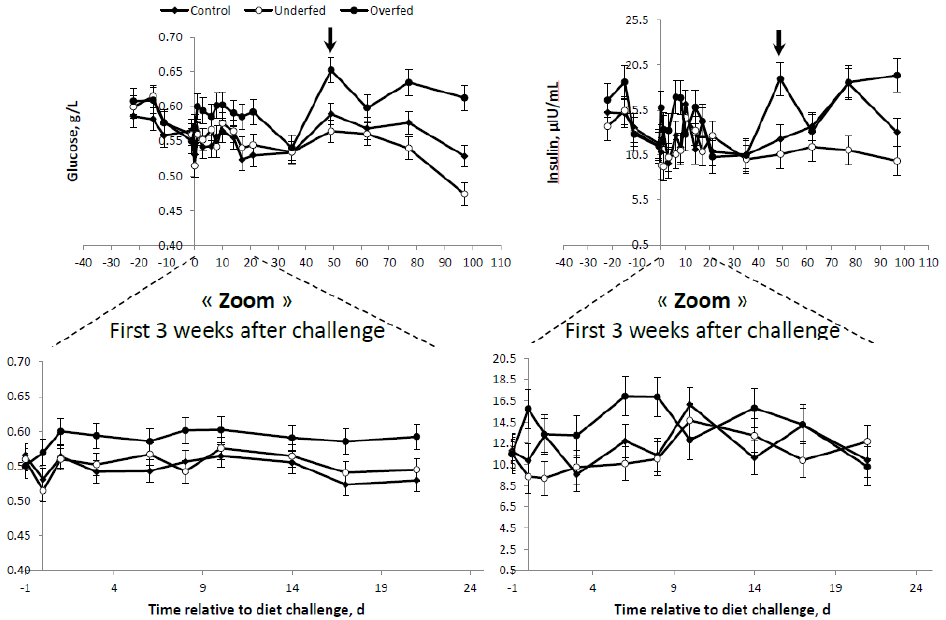
Figure 3. Plasma glucose and insulin concentrations of mature, dry, nonpregnant Merinos d’Arles ewes ( n = 36) offered different diets, i.e., 70% (underfed; n = 12), 100% (control; n = 12) or 160% (overfed; n = 12) of maintenance energy requirements. Diet challenge started at day 0, after a 3-week adaptation period. Arrow represents commencement of refeeding period. Bars are SEM.